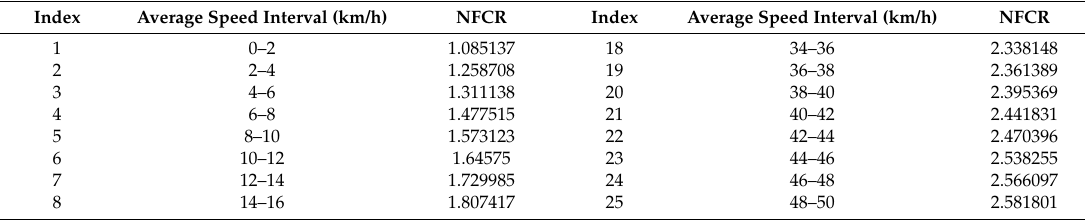
Table 3. Normalized fuel consumption rate (NFCR) according to average speed